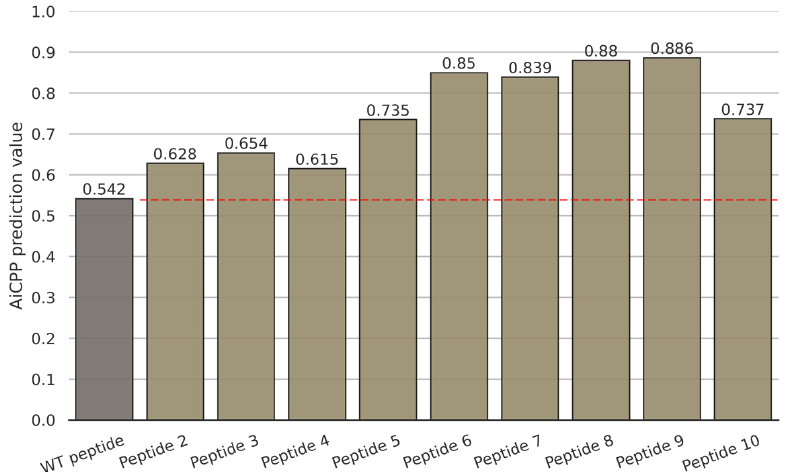
Figure 9. AiCPP prediction values for nine optimized peptides. The bar graph shows the AiCPP scores, with the red dashed line indicating the score of the WT peptide.